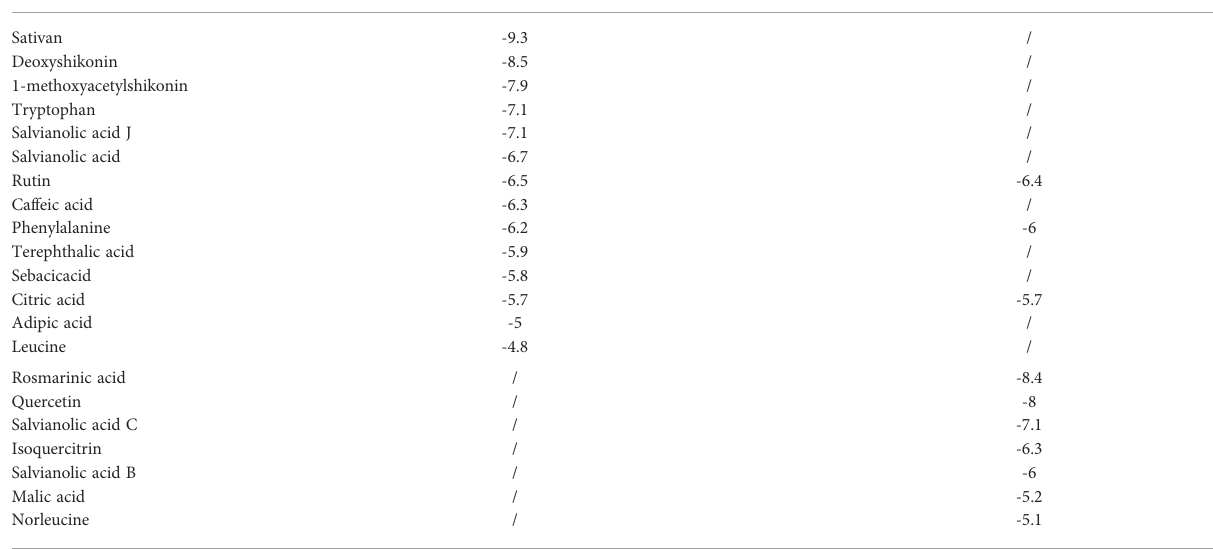
TABLE 2 Estrogen receptor ligands binding